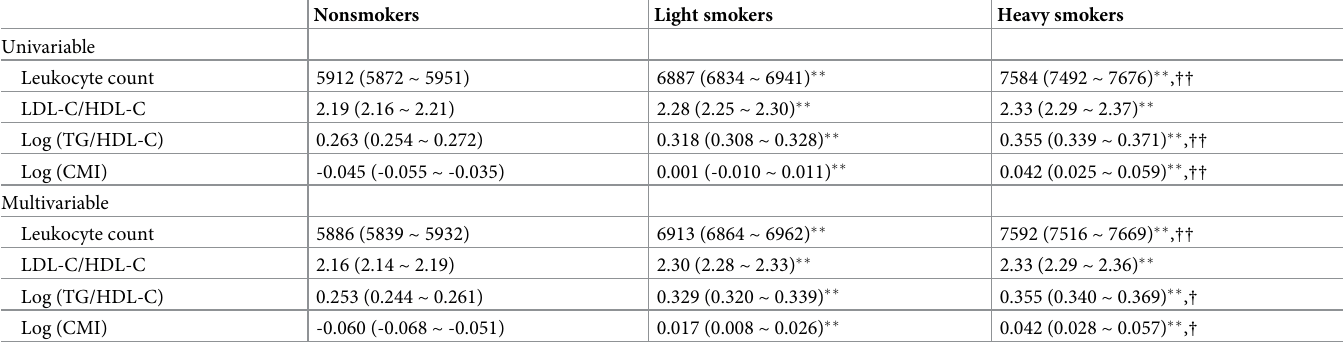
Table 2. Comparison of mean levels of leukocyte count and lipid-related indices in non-, light and heavy smokers in overall subjects. Nonsmokers